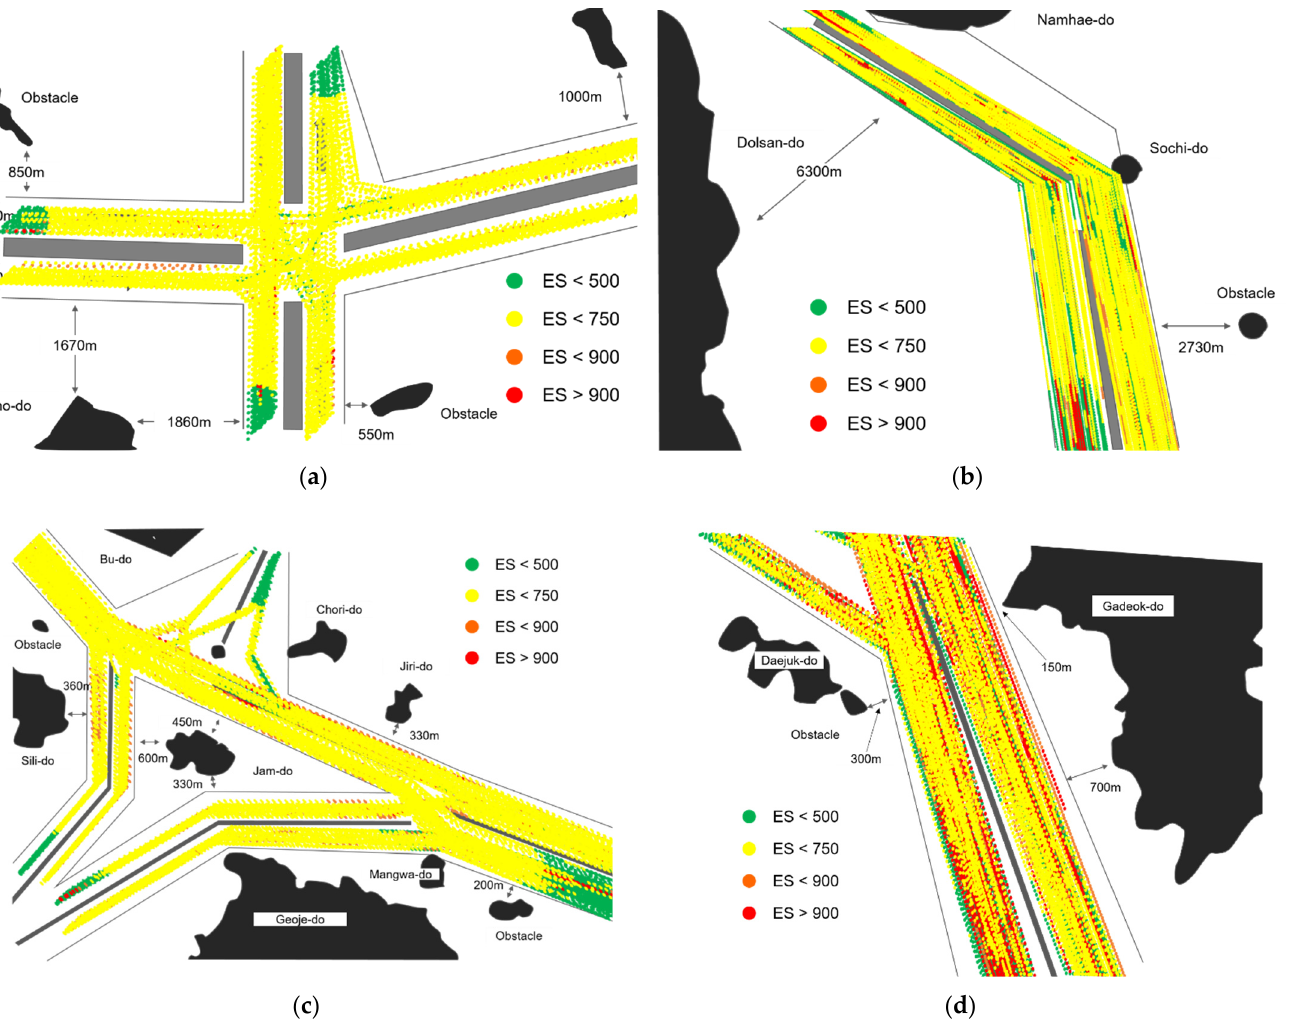
Figure 8. ( a ) Collision risk evaluation result for the Wando fairway, ( b ) the Yeosu fairway, ( c ) the Masan fairway, and ( d ) the Gadeok fairway. Green indicates ES values less than 500, yellow indicates ES values less than 750, orange indicates ES values less than 900, and red indicates ES values of 900 or more.